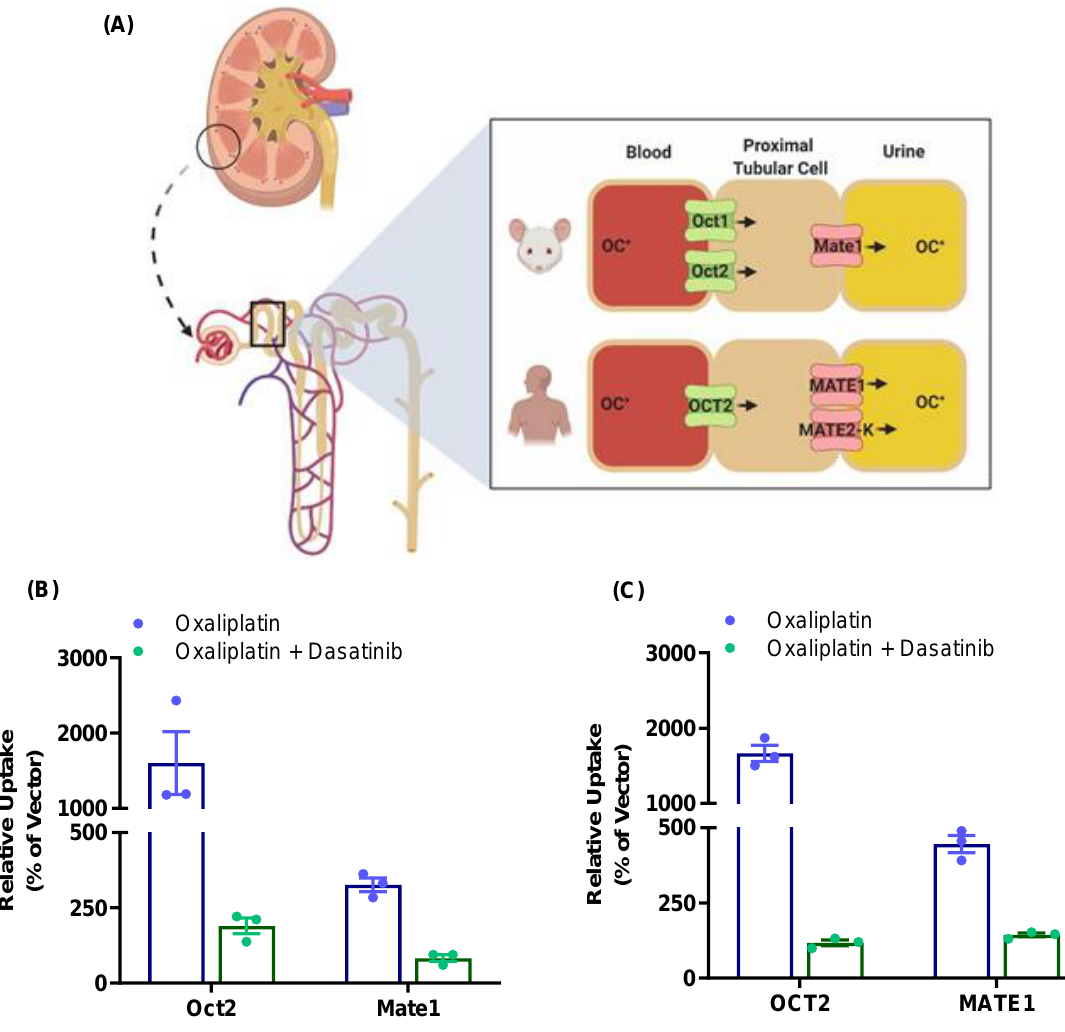
Figure 5. Renal transport of oxaliplatin in mice and humans. ( A ) Scheme depicting vectorial transport of organic cations (OC+) in the kidney of mice and humans. Transport activity of oxaliplatin (50 µM) was assessed in HEK293 cells overex- pressing mouse ( B ) and human ( C ) OCT2, or MATE1 transporters in the presence or absence of dasatinib (10 µM).